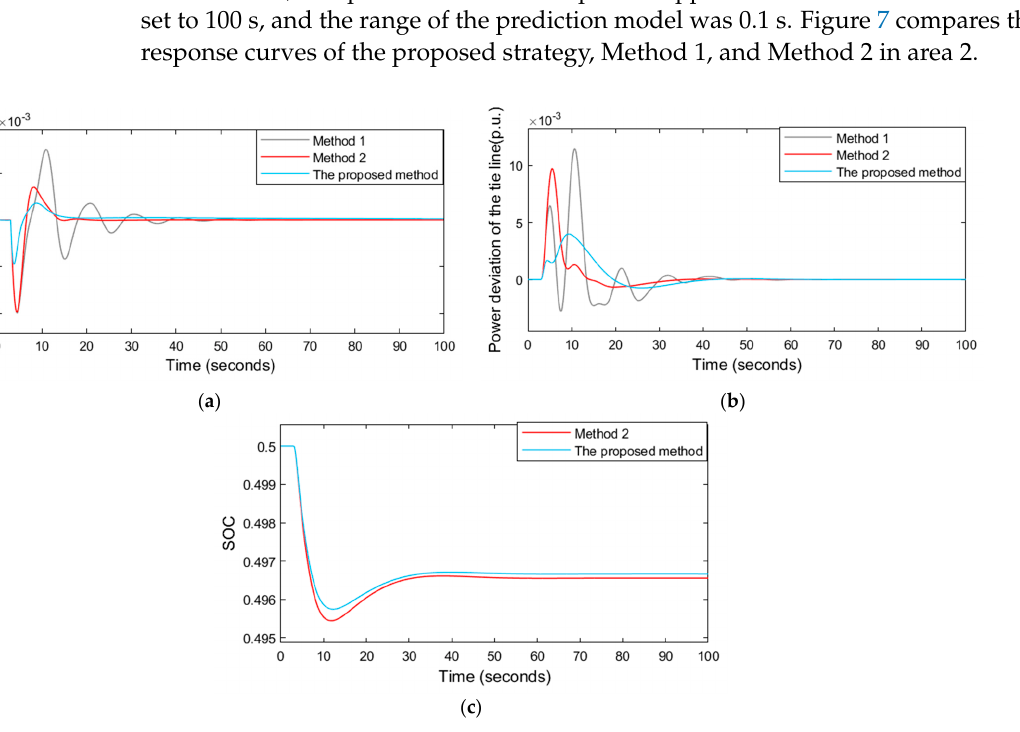
Figure 7. System response with step disturbance. ( a ) Description of the frequency deviation re- sponse curve. ( b ) Description of the tie-line power bias. ( c ) Description of change in SOC.